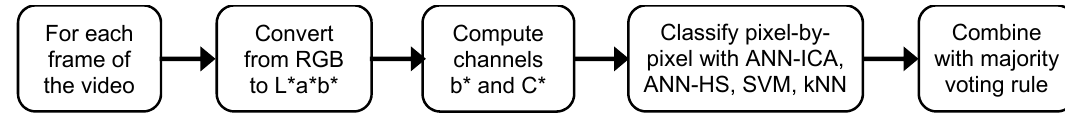
Table 8. Comparison of the accuracy of the segmentation algorithms reported in different works. Correct Classification Rate (%) Number of Samples Method